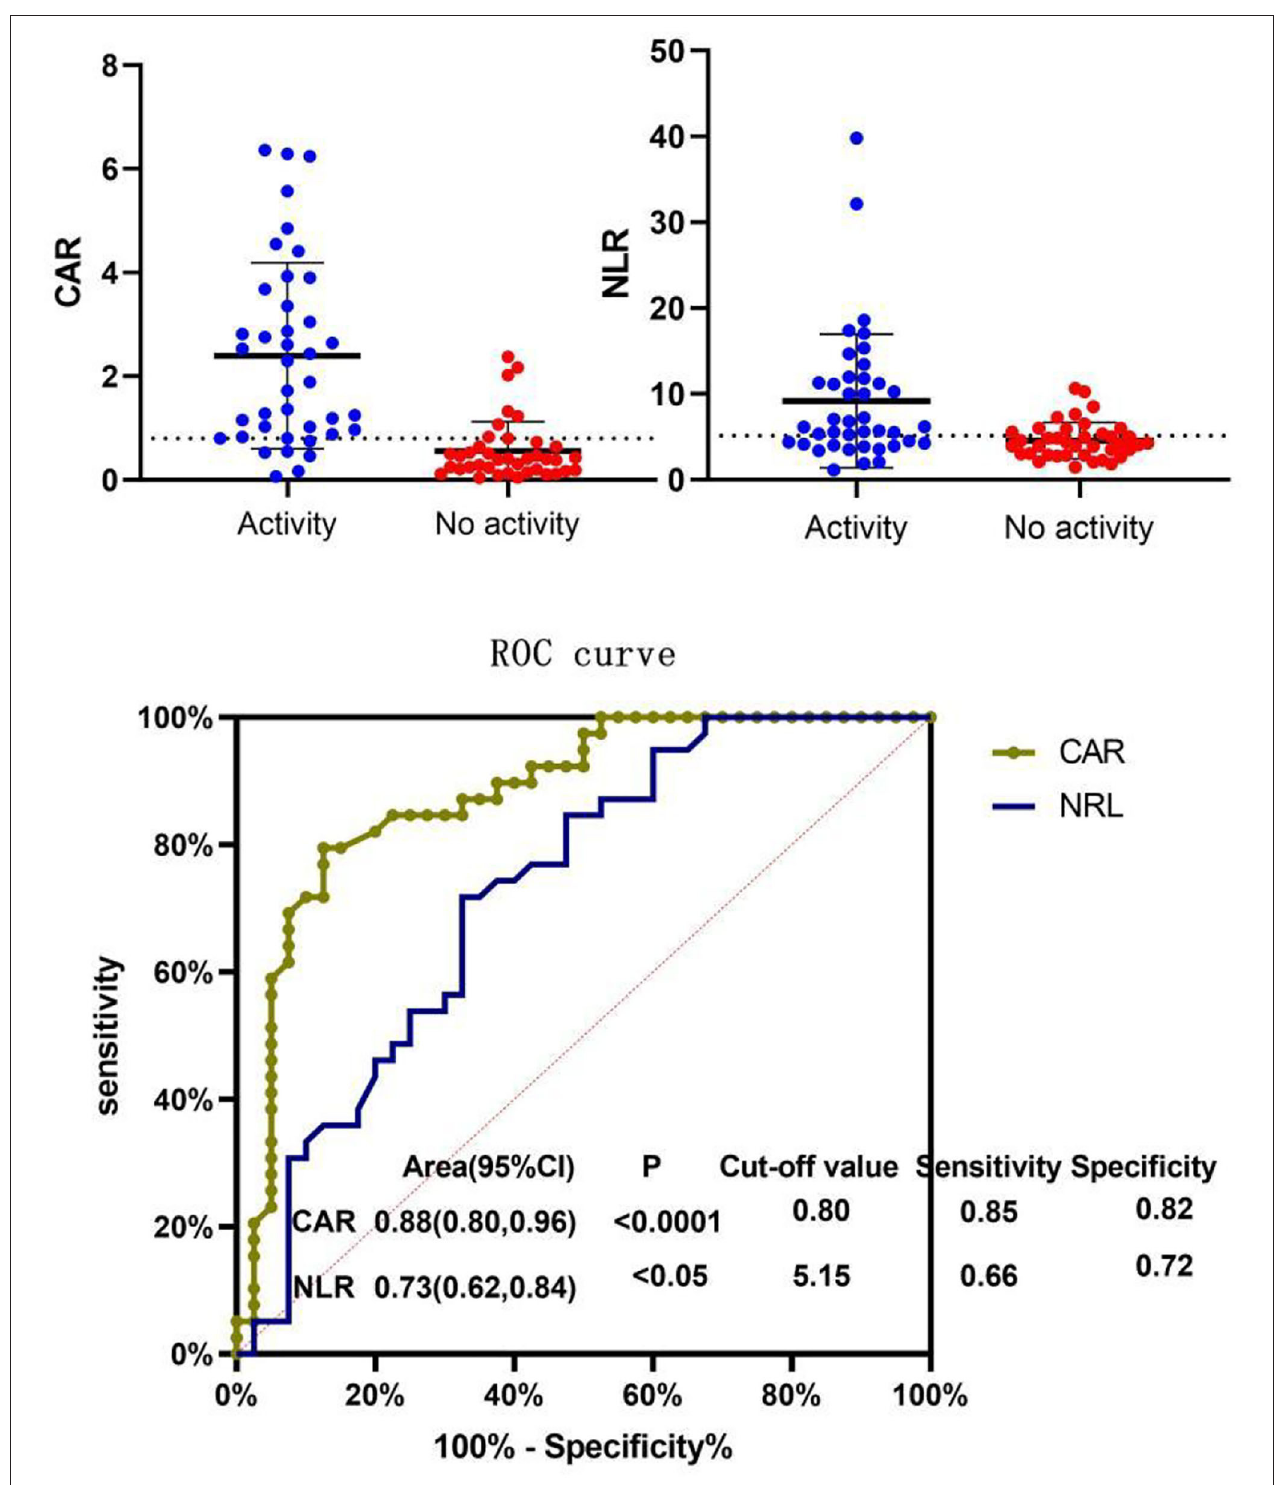
FIGURE 3 | Receiver operating characteristic (ROC) curve of NLR and CAR for BVAS. Patients were divided into the active disease group (BVAS > 15) and the non-active disease group (BVAS ≤ 15) and ROC curve analysis was conducted for the CAR and NLR. The optimal cutoff value for disease activity evaluation using the CAR was 0.80 (sensitivity: 85% and specificity: 82%, P < 0.05). The optimal cutoff value for disease activity evaluation using the NLR was 5.15 (sensitivity: 66% and specificity: 72%, P < 0.05). CAR, C-reactive protein/albumin ratio; NLR, neutrophil/lymphocyte ratio; MPV, mean platelet volume; BVAS, Birmingham Vasculitis Activity